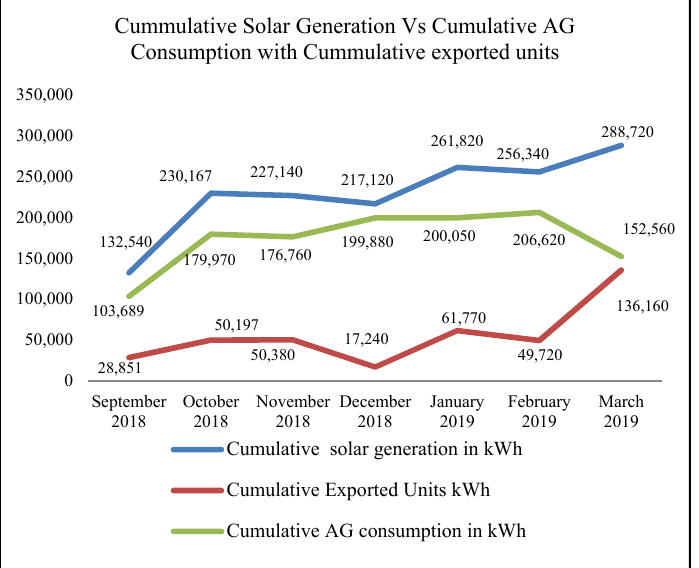
Figure 3. Comparison of cumulative solar generation versus cumulative AG consumption with cumulative units exported (kWh).